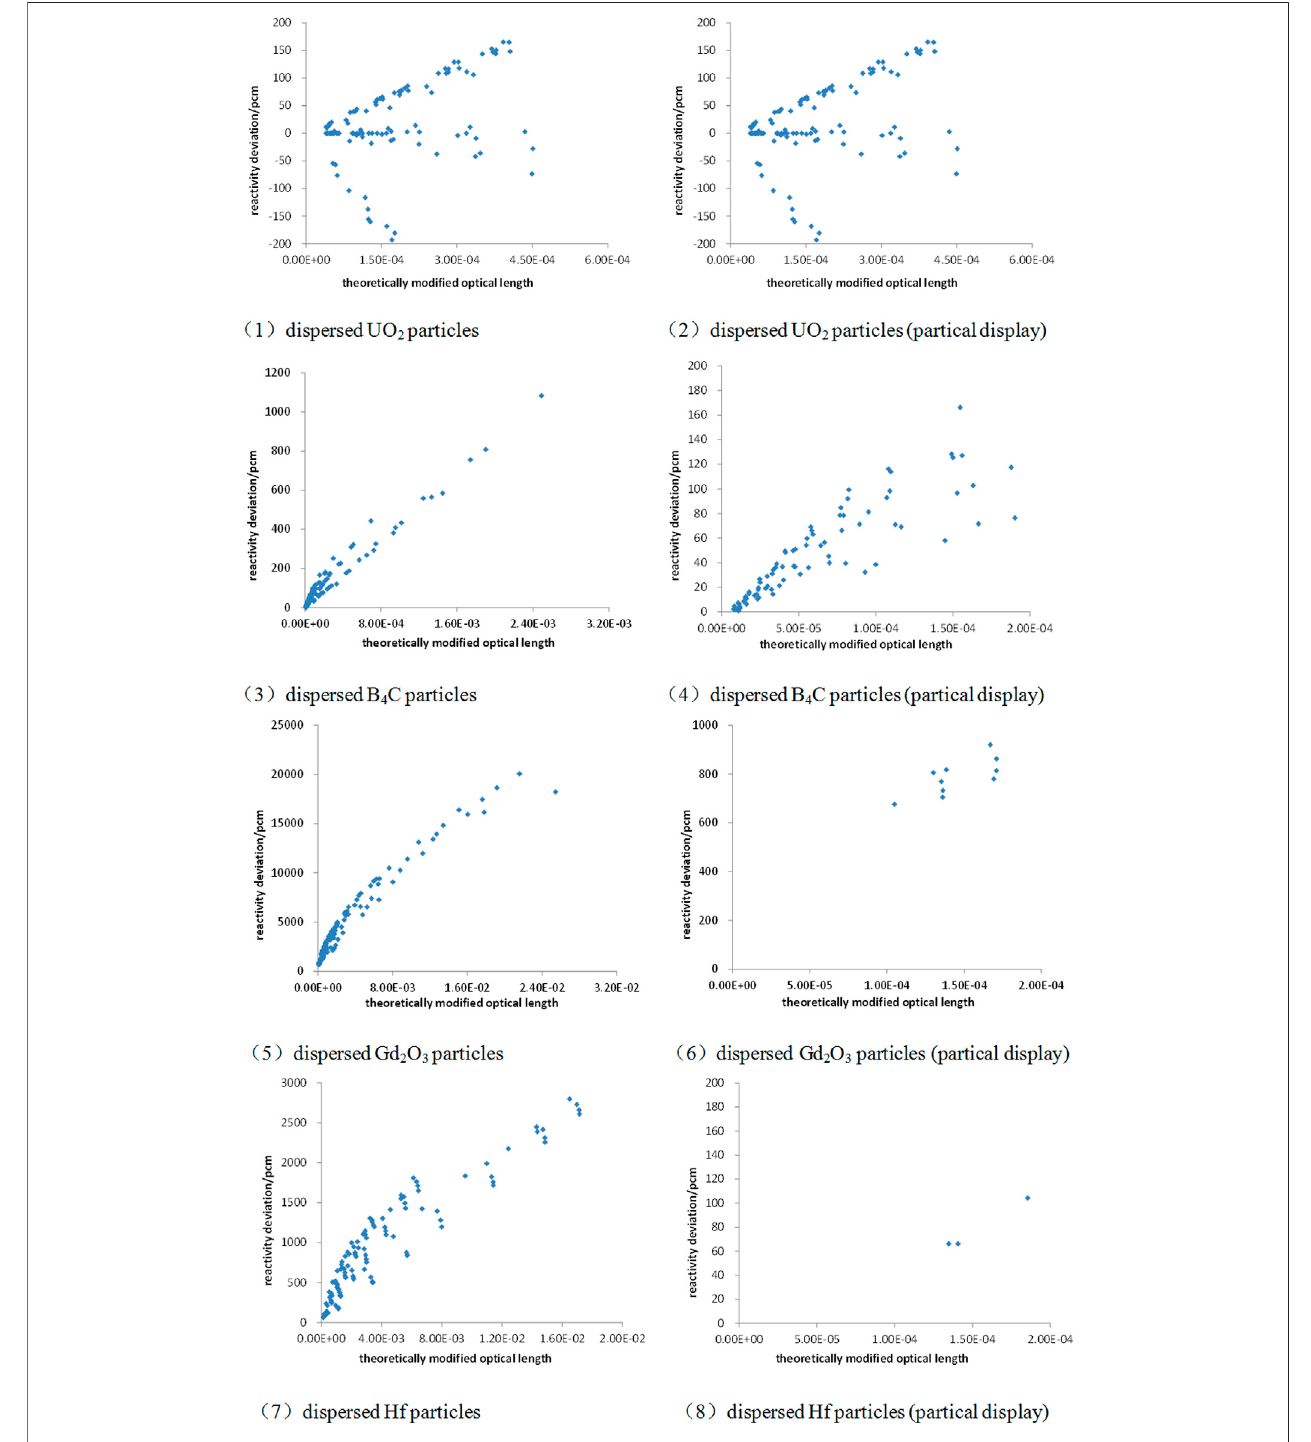
FIGURE 6 | Relationship between reactivity deviation and optical length or theoretically modi fi ed optical length.